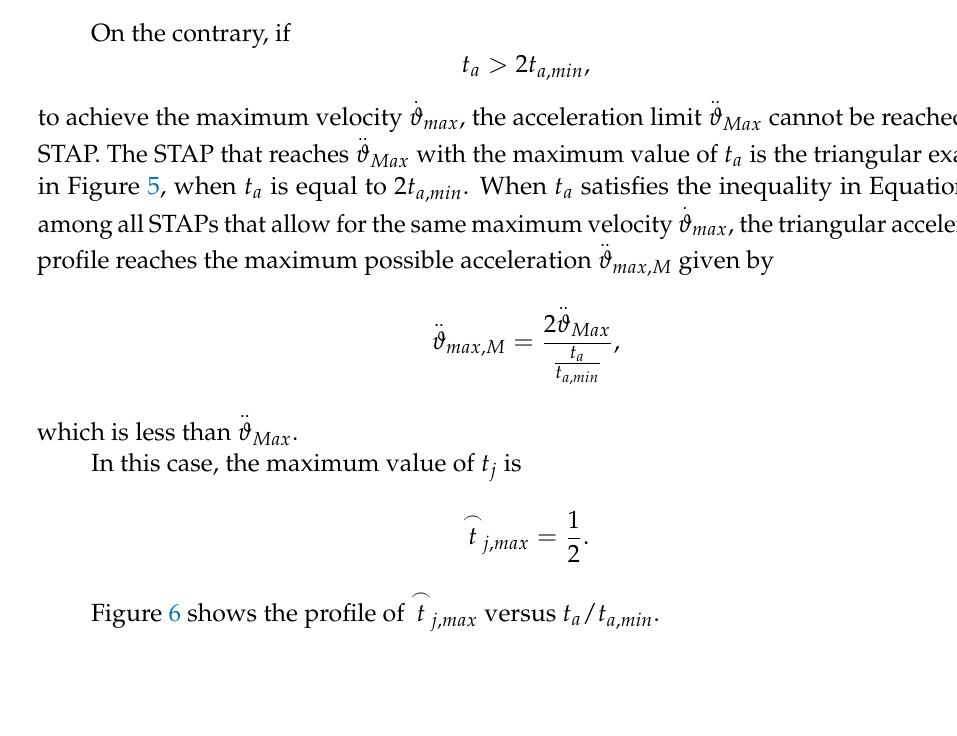
Figure 5. Dimensionless trapezoidal acceleration profiles when the inequalities in Equation (25) are met.